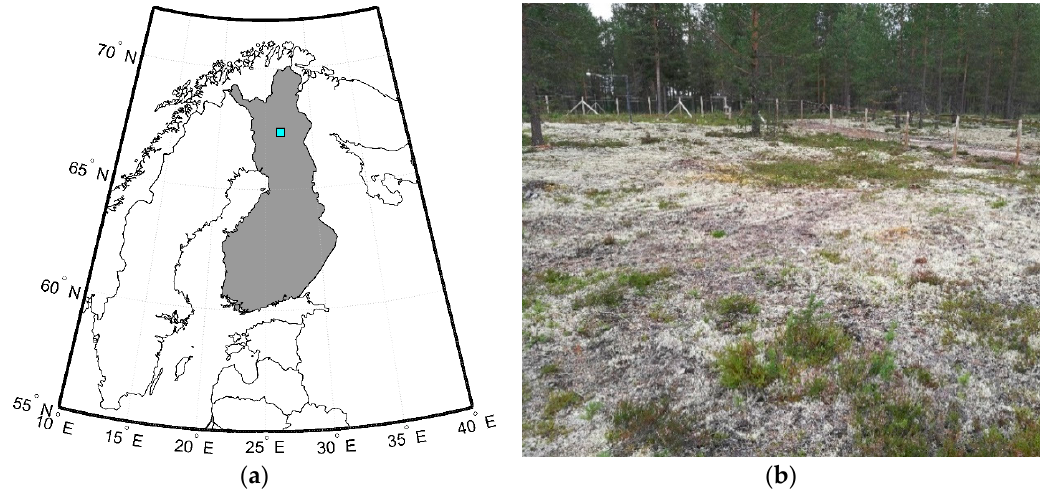
Figure 1. ( a ) Location of Sodankylä in northern Finland; ( b ) snow pit measurement site in